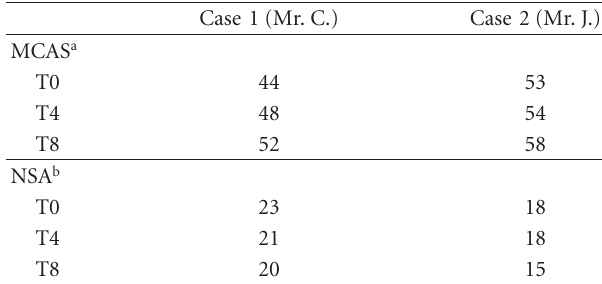
Table 2: Scores on the measures of functional outcome for the two cases.